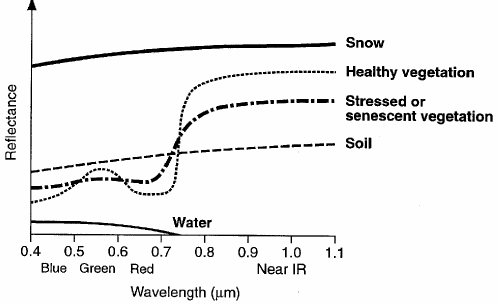
Figure 16. Spectral reflectance curves of snow, healthy and stressed vegetation, soil and water (Harris,